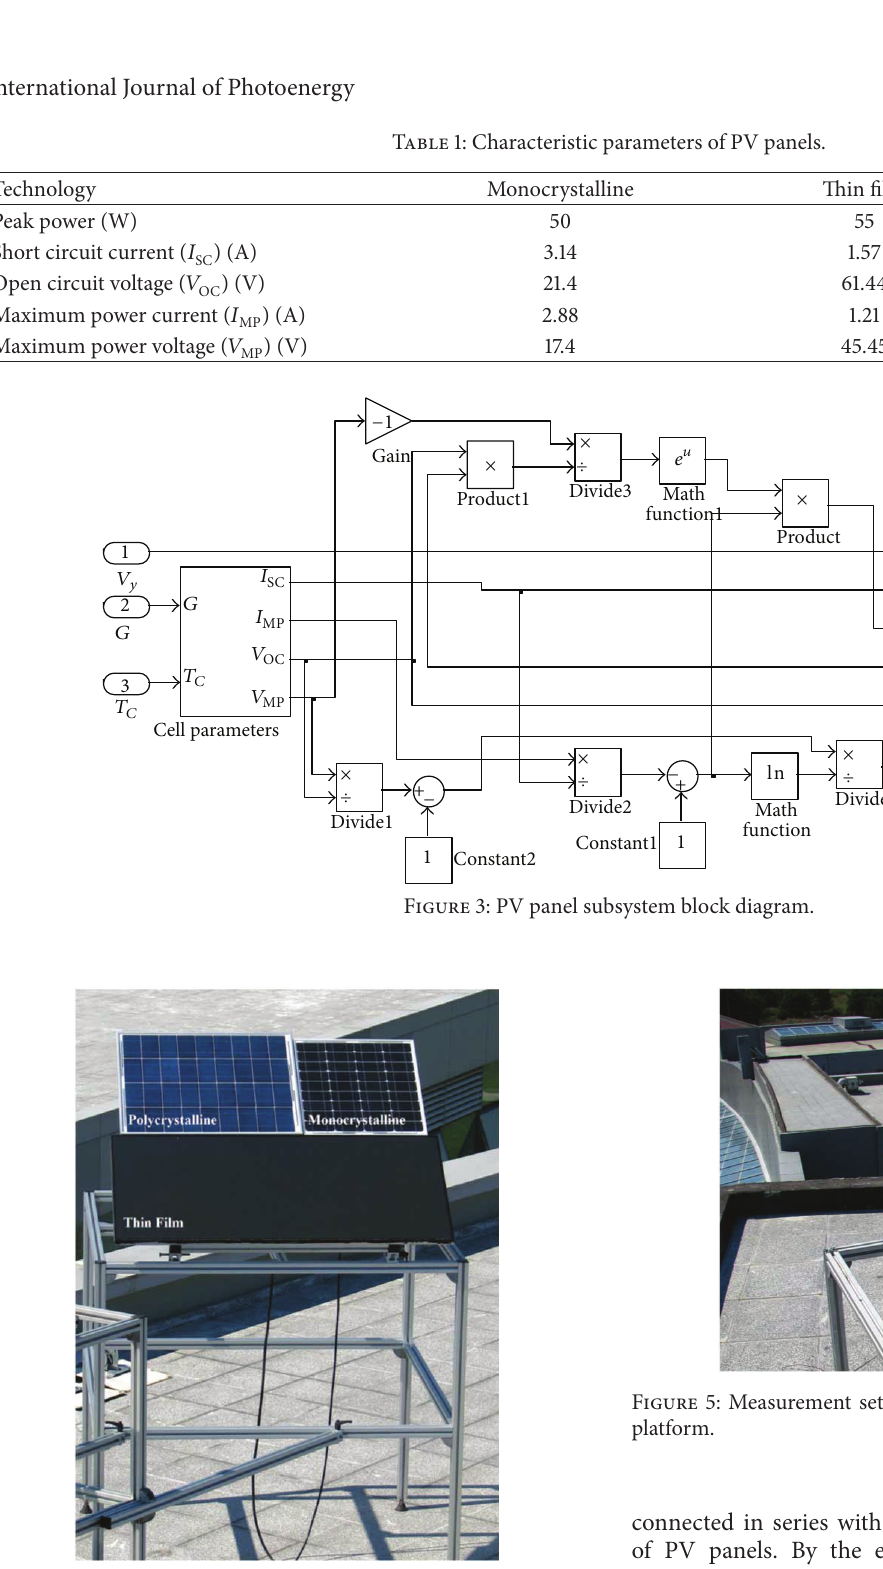
Figure 4: The platform with three different PV panel technologies positioned with 41 ∘ tilt angle.